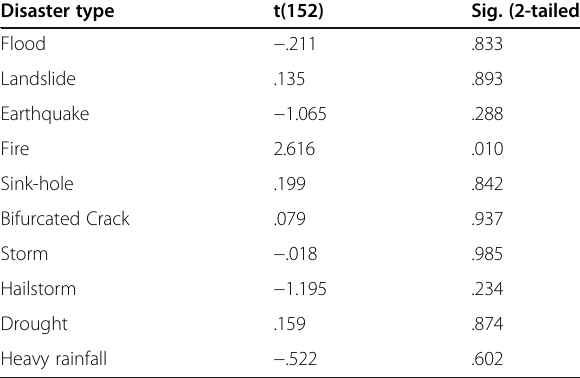
Table 7 t-test result for age-based group ’ s (< 40 years and > 40 years) opinion on level of danger during major disaster